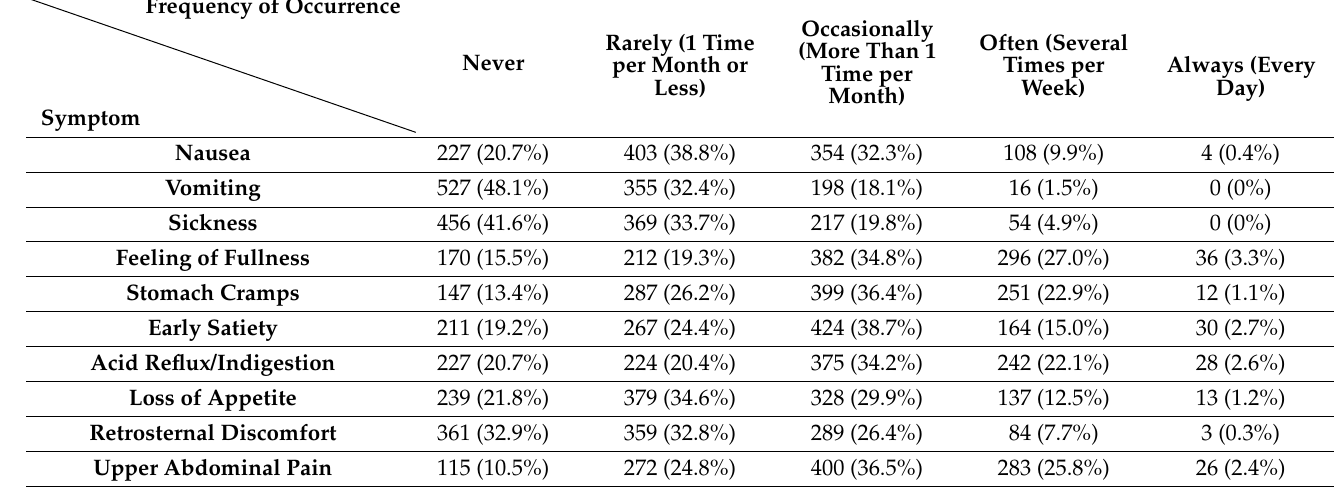
Table 3. Frequency of occurrence for the gastrointestinal 10 symptoms.